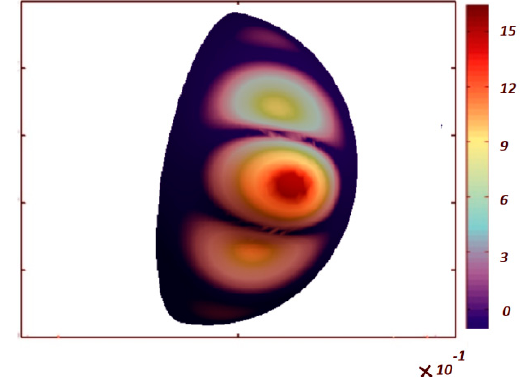
Figure 3. The first six buckling mode shapes of an FG-GPL, porous spherical cap ( ϑ = 180 ◦ , φ = 180 ◦ , GPL-X, PD1, e 0 = 0.4, γ = 0.01 wt%).